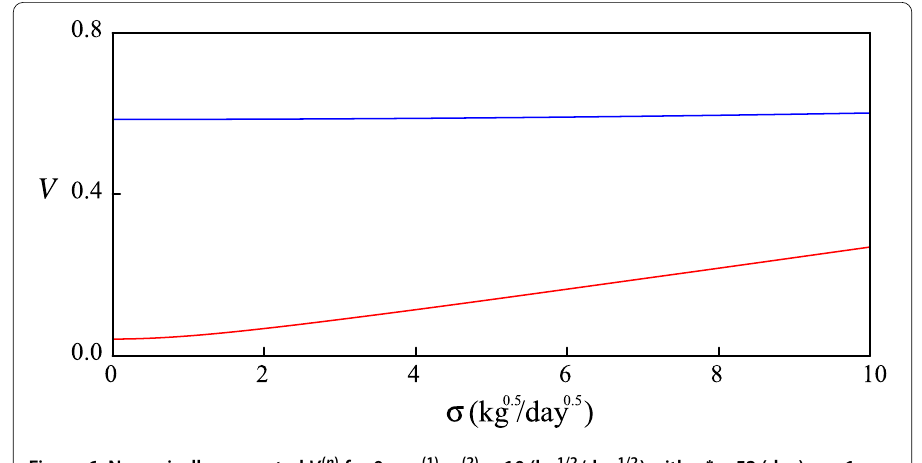
Figure 6 Numerically computed V ( n ) for 0 ≤ σ (1) , σ (2) ≤ 10 (kg 1/2 /day 1/2 ) with τ ∗ = 52 (day): n = 1 (harvesting for sale, red) and n = 2 (harvesting for ecological education,